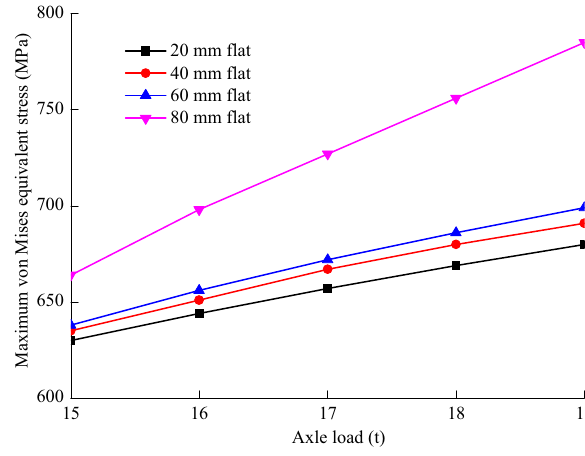
Fig. 11 Maximum equivalent plastic strain versus flat length